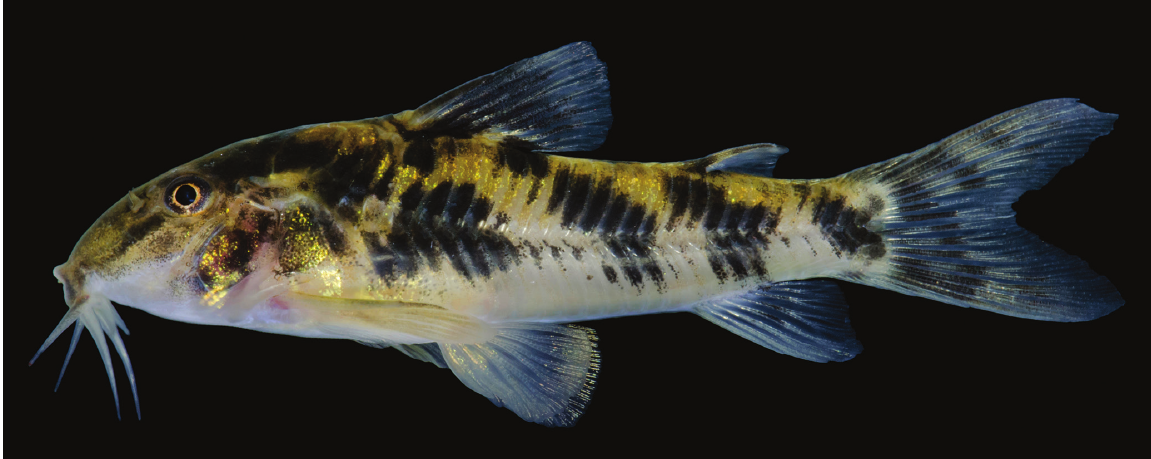
Fig. 2. Aspidoras kiriri , holotype, MNRJ 47400, 30.6 mm SL, Brazil, Bahia, Serra da Jibóia, Varzedo, rio da Dona basin, riacho Cai-Camarão. Lateral view. Photographed in